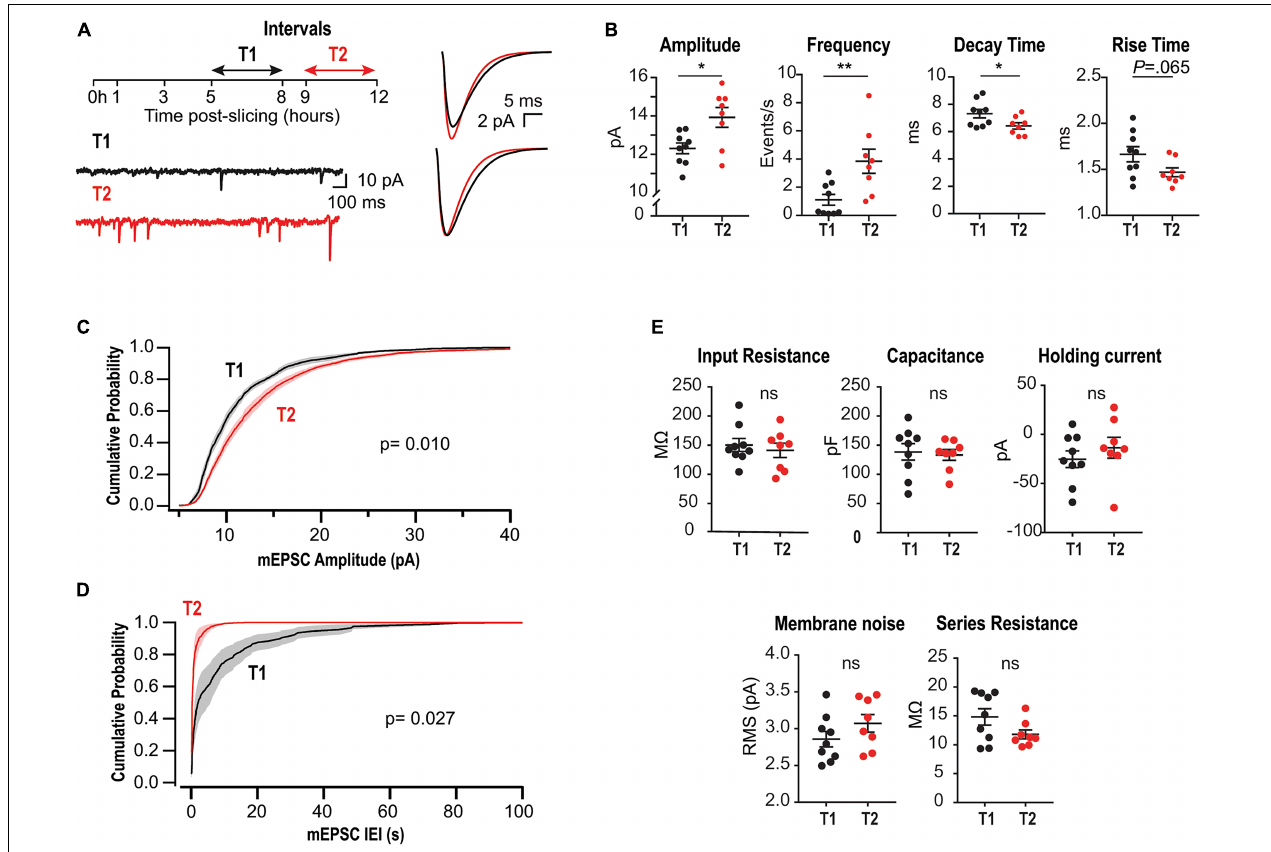
FIGURE 1 | Upregulation of mEPSCs amplitude and frequency in acute slices lacking CA3. (A) Left, experimental design and representative somatic current recordings from two different neurons at early (T1) and late (T2) stages. Right, superimposed average mEPSCs waveforms (above) and rescaled traces (below). (B) Summary plots for mEPSCs amplitude, frequency, rise and decay times for all recorded neurons. Each point corresponds to the mean value from a single neuron. (C) Amplitude cumulative probability distributions of all mEPSC recorded at T1 or T2. (D) Interevent interval (IEI) distributions. Random permutation test. (E) Membrane properties and series resistance for the two cell populations (Unpaired t -test). N = 9 cells for T1 and N = 8 for T2, recorded from 6 rats (1–4 slices per